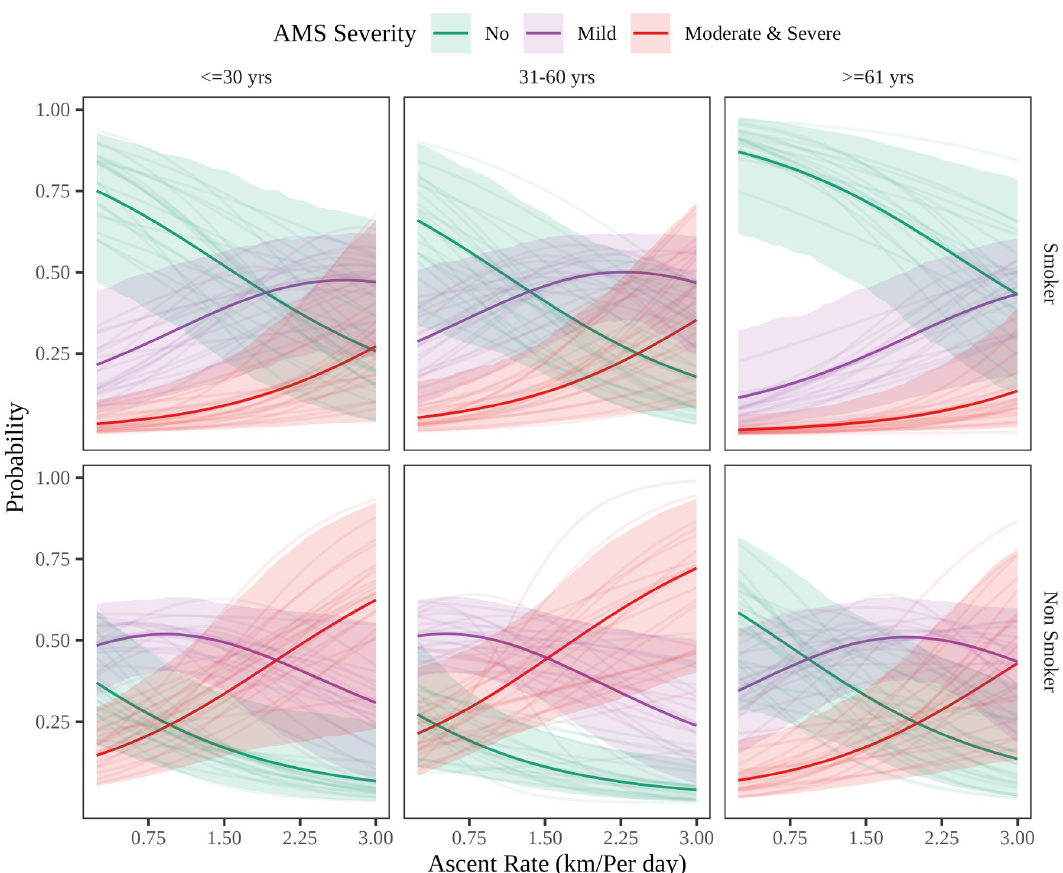
Fig 2. The counterfactual probability plot for AMS severity with ascent rate, age, and smoking status derived from model 4 of Table 2. The baseline is represented by a male with no comorbidities, with a permanent address at an altitude of 542m (median in the dataset), reaching the peak altitude of 3800m (altitude of Muktinath temple) without drinking alcohol during the ascent. Bold lines are posterior means. Shaded areas are posterior 95% credible intervals, and thin lines are sampled fitted lines from the posterior. For a middle-aged (31–60 years), non-smoker male travelling from Pokhara to Muktinath in a single day, the odds of developing moderate or severe AMS increase twofold (2.069) compared to those of a three-day